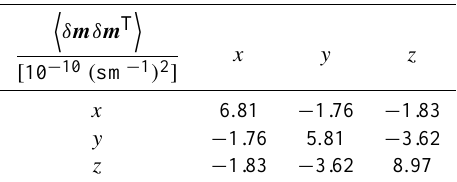
Table 2. Crossing time error analysis using a tanh pattern func- tion: elements of the slowness error covariance matrix